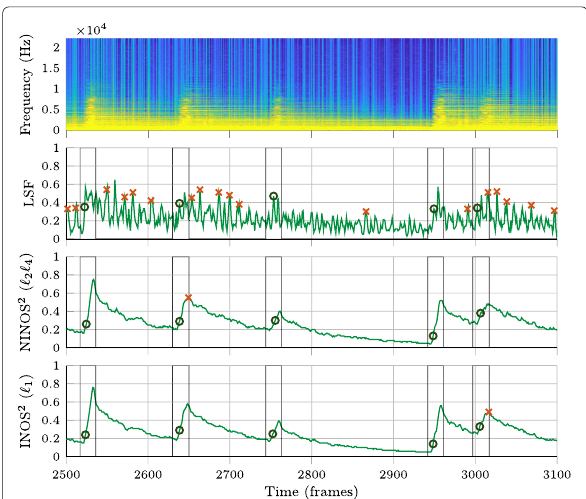
Fig. 6 Comparison of ODFs and peak-picking results for electric guitar (major seventh stopped) excerpt. Vertical lines represent onset detection windows indicating ground-truth onsets. Circles are used to mark true positives in the peak-picking results, while false positives are marked with crosses